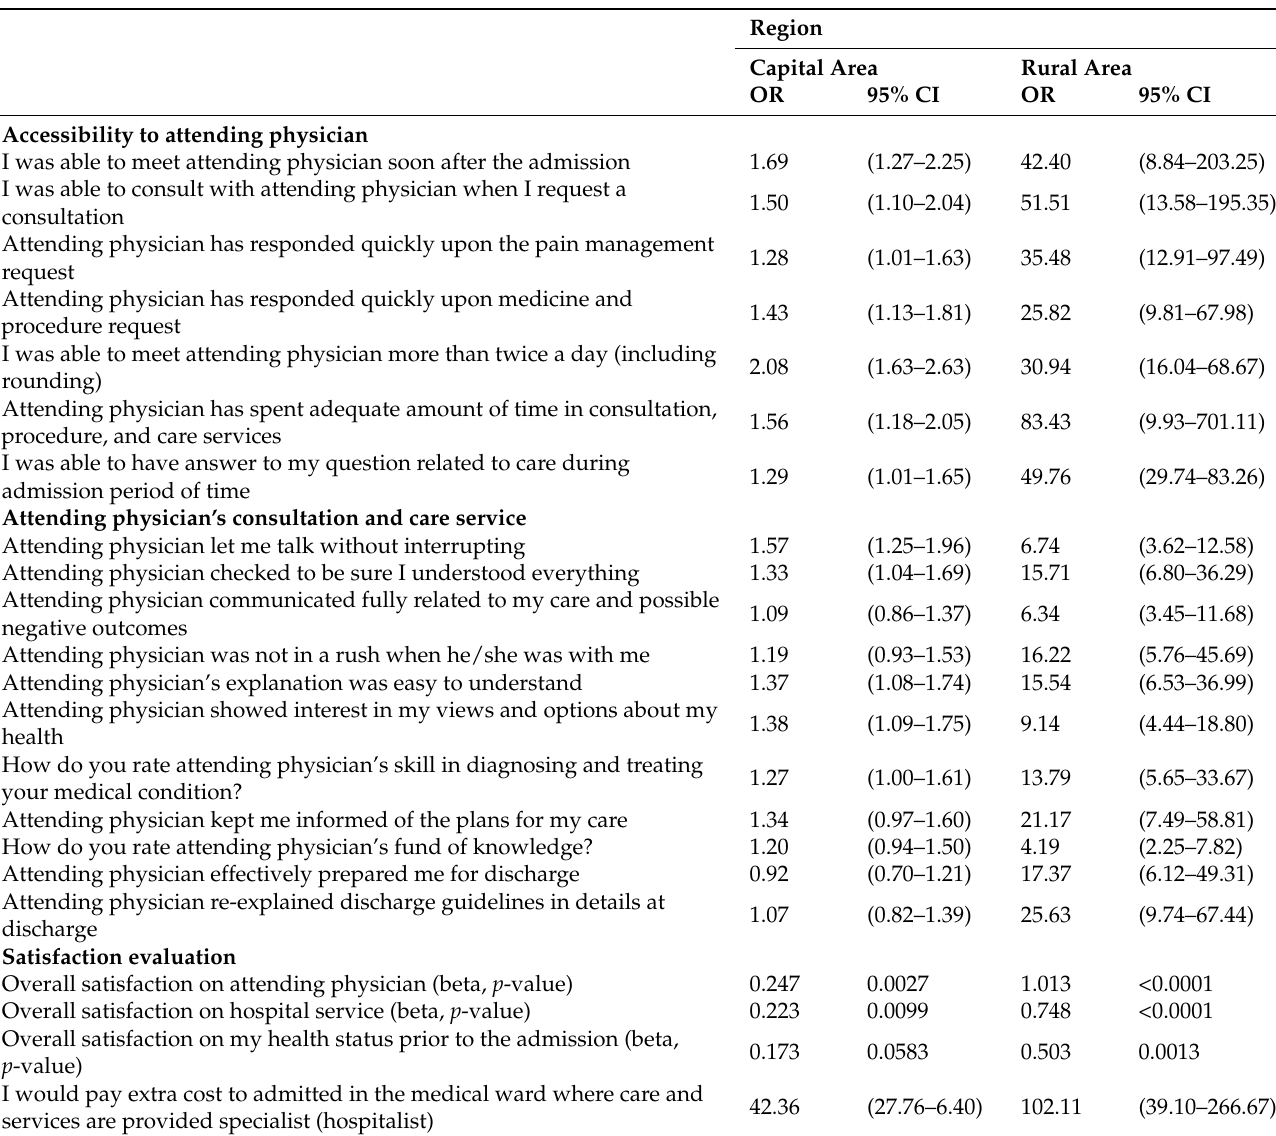
Table 4. Results of logistic regression on the patient satisfaction on attending physician in the hospitalist ward compared to the non-hospitalist ward by region ‡